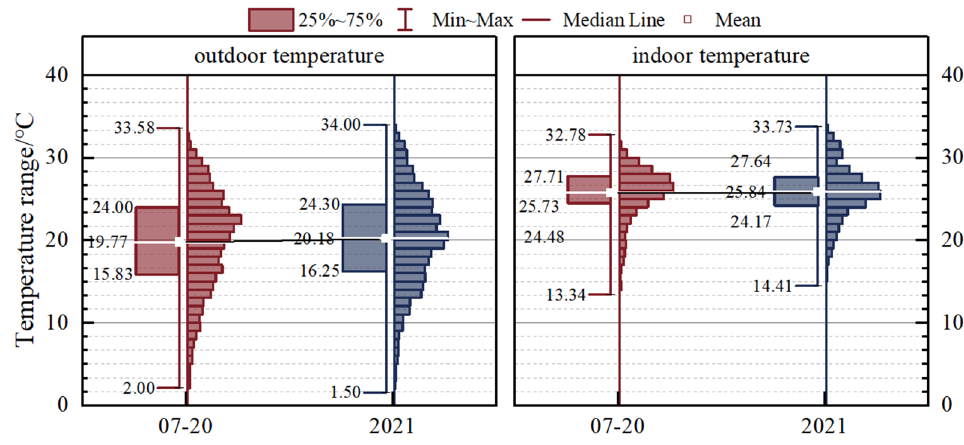
Figure 11. Outdoor temperature and indoor temperature from May to September for 2007–2020 and 2021.